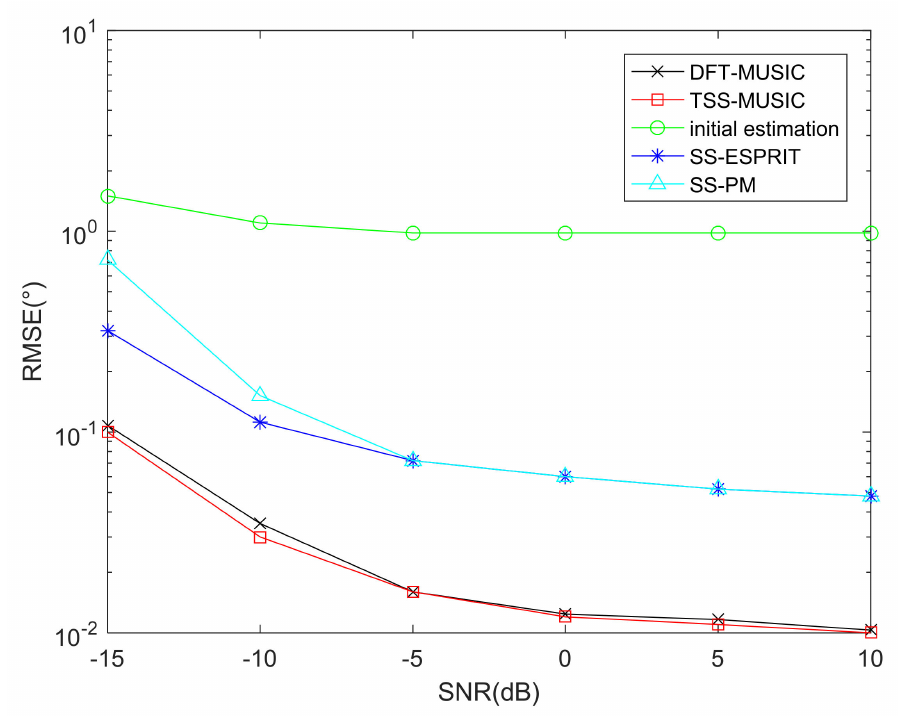
Figure 10. RMSE performance comparison of different